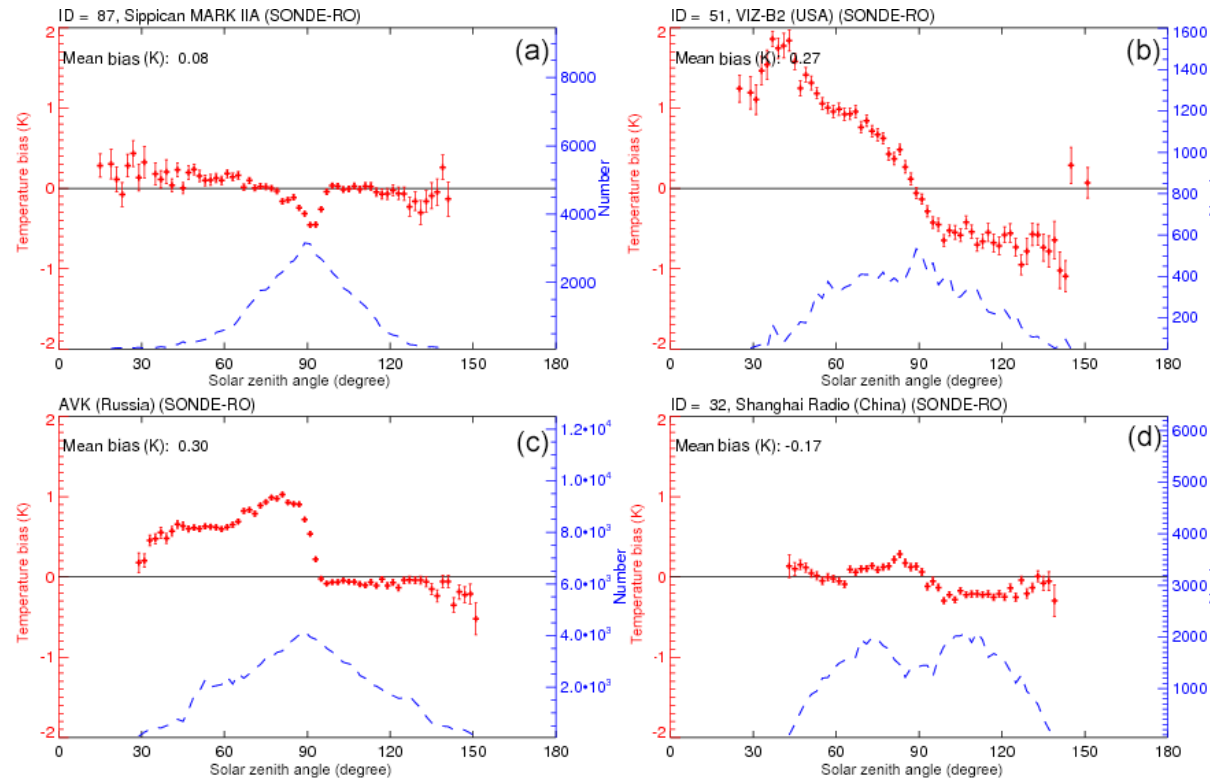
Figure 8. The mean temperature biases at 50hPa varying for SZA from 0 to 180 ◦ for (a) Sippican over United States minus RO, (b) VIZ-B2 over United States minus RO, (c) Russian sonde minus RO, and (d) Shanghai minus RO. Only bins for more than 50 RAOB–RO pairs are plotted. Table 4. Mean, standard deviation (SD), de-seasonalized trend of temperature differences (K/5yr), and root mean square (RMS) of de- seasonalized time series of RAOB minus RO temperature difference at 50hPa for global Vaisala (RS80, RS90, and RS92), and other sensor